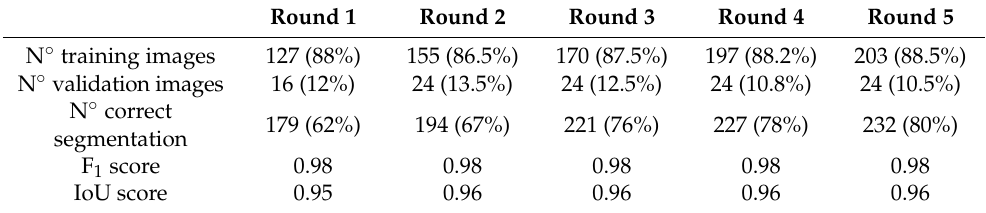
Table 3. Results obtained by the EfficientNet-b3 model in the ASSL training strategy on the PetWound dataset. For each round, we reported the number of images used for the training and validation of the model, the number of correctly annotated images, and the segmentation metric scores. We considered as Round 0 the one performed with the model trained only on the Deepskin dataset.